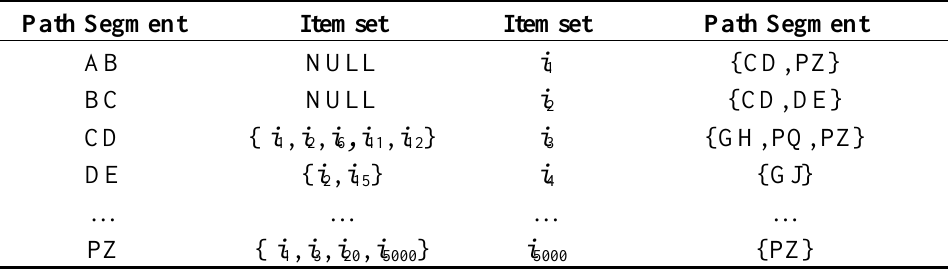
Figure 2. An illustration of path graph ( a ) A photo of Real supermarket. ( b ) An illustration of a part of supermarket after RFID deployment. ( c ) An illustration of a part of path graph after mapping. Table 3. An example of SIT and IST